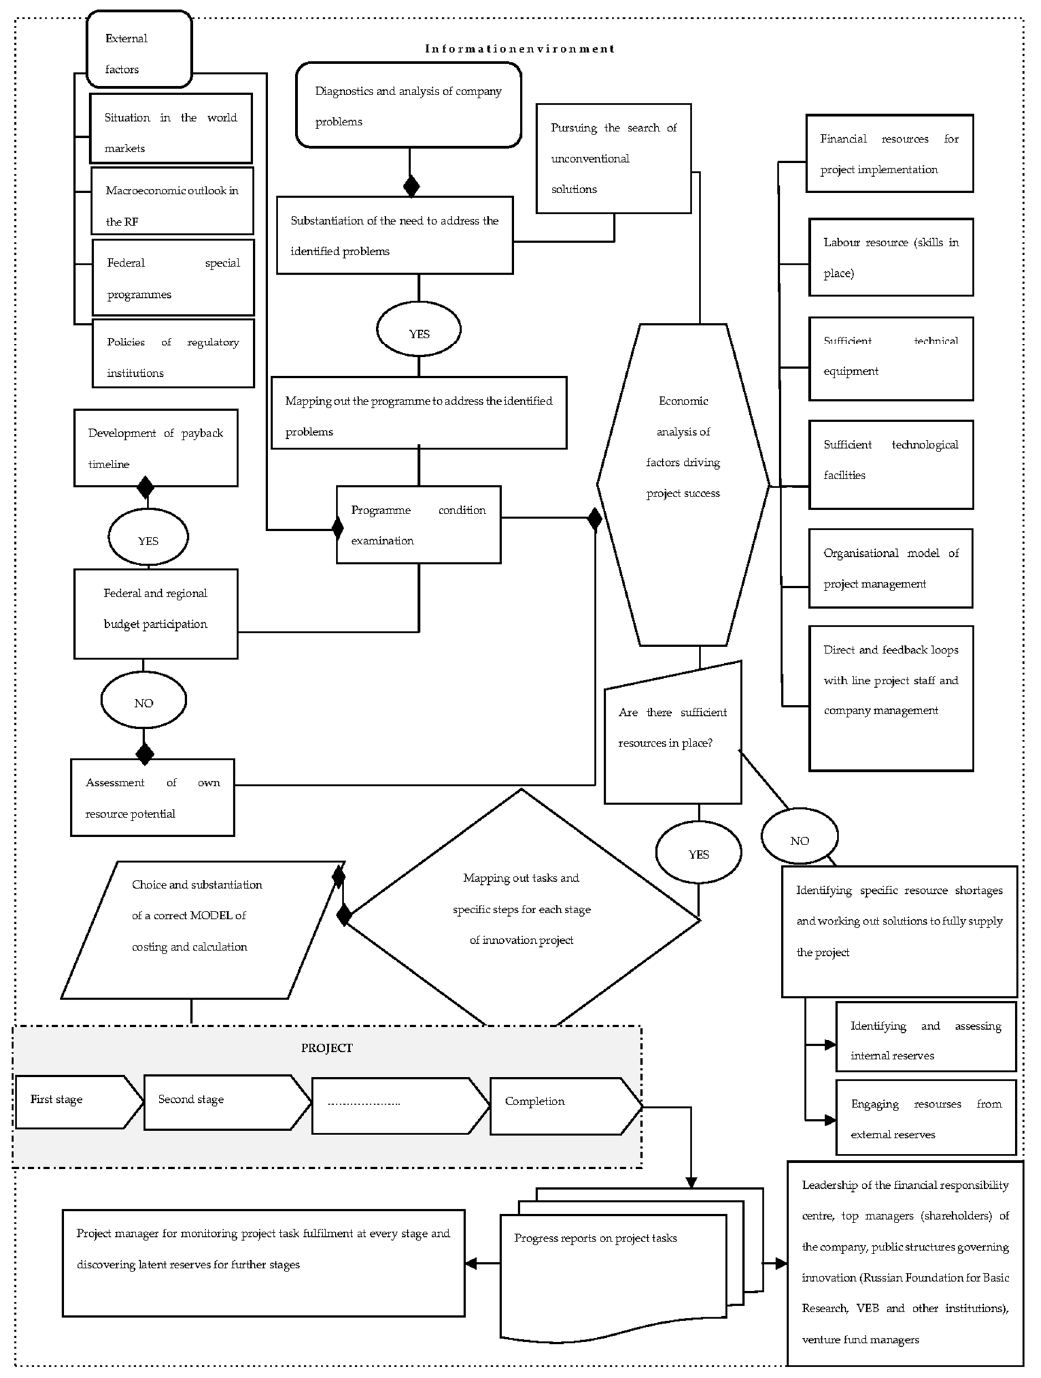
Figure 7. Objective ‐ based management of an innovation project as an object. Figure 7. Objective-based management of an innovation project as an